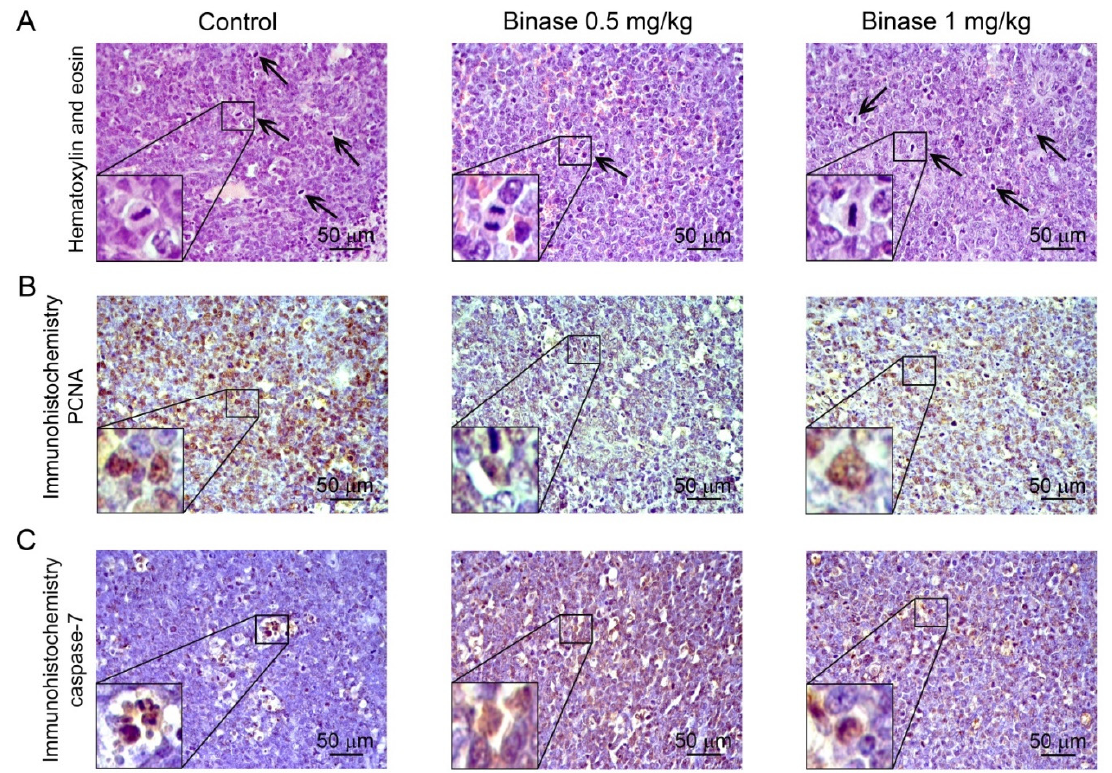
Table 2. Morphological organisation of RLS 40 tumour tissue.